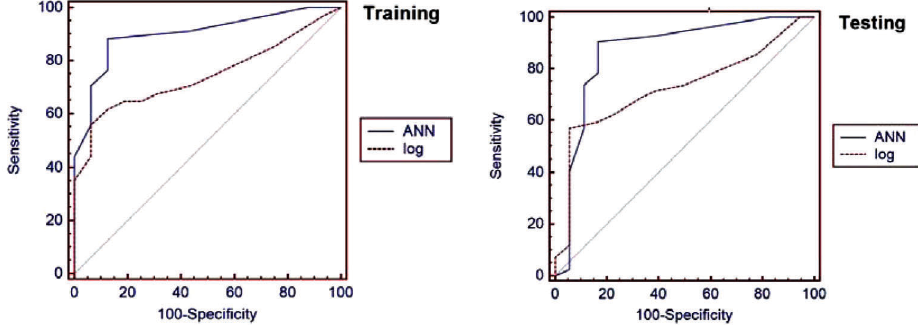
Figure 3. Comparison of ROC curves for artificial neural network (ANN) and logistic regression analysis in both training and testing